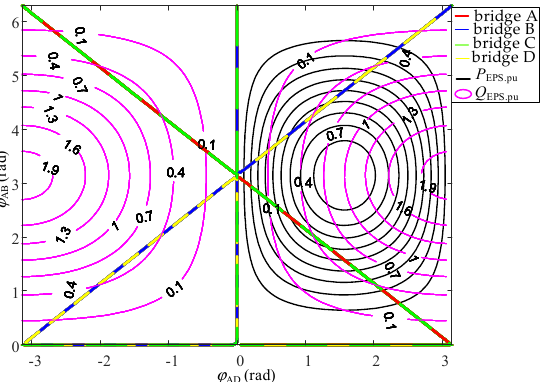
Figure 9. Intersection of active power and reactive power contours under EPS modulation ( M = 1).